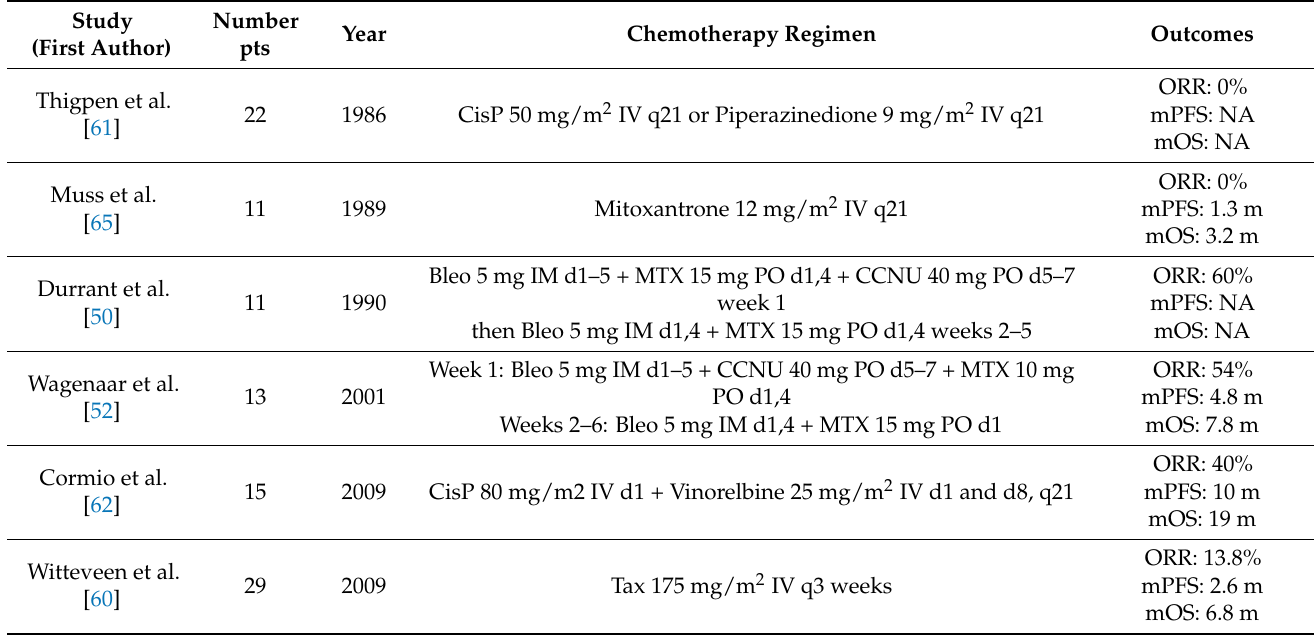
Table 4. Summary of studies with more than 10 patients exploring chemotherapy alone in recurrent/metastatic vulvar